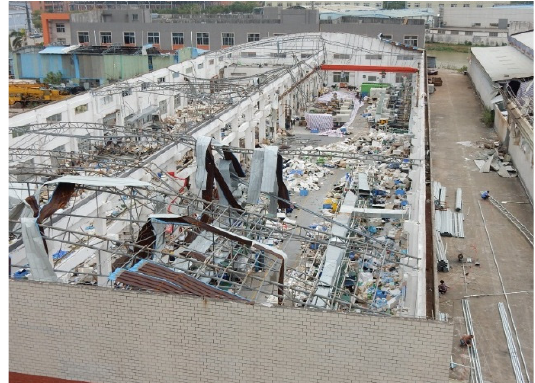
Figure 3. Mainframe collapsed during the typhoon event [6].